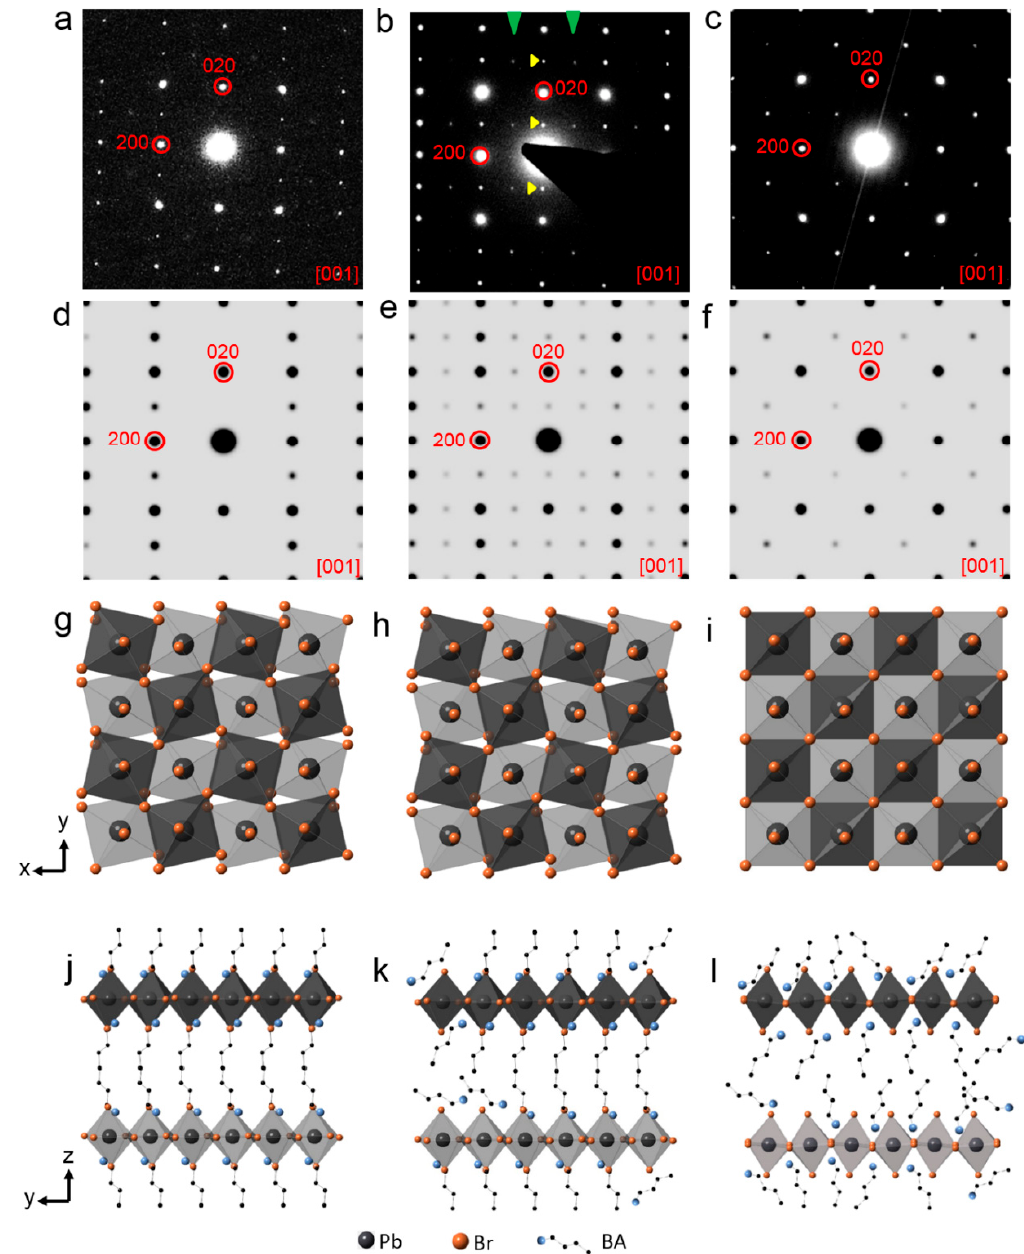
Figure 5. ( a – c ) Representative SAED patterns obtained from BA 2 PbBr 4 nanosheets exposed to UV light or white light at the initial state, intermediate state, and excessive state, respectively. ( d , g , j ) Simulated [001] electron diffraction of the initial BA 2 PbBr 4 structure with the corresponding illustration from [001] top view and [100] side view, respectively. ( e , h , k ) Simulated [001] electron diffraction of the BA 2 PbBr 4 structure where organic moieties were partially disordered with the corresponding illustration from [001] top view and [100] side view, respectively. ( f , i , l ) Simulated [001] electron diffraction of the BA 2 PbBr 4 structure where organic moieties were disordered and [PbBr 6 ] 4– octahedra were tilt-ordered along <110>, with the corresponding illustration from [001] top view and [100] side view, respectively.